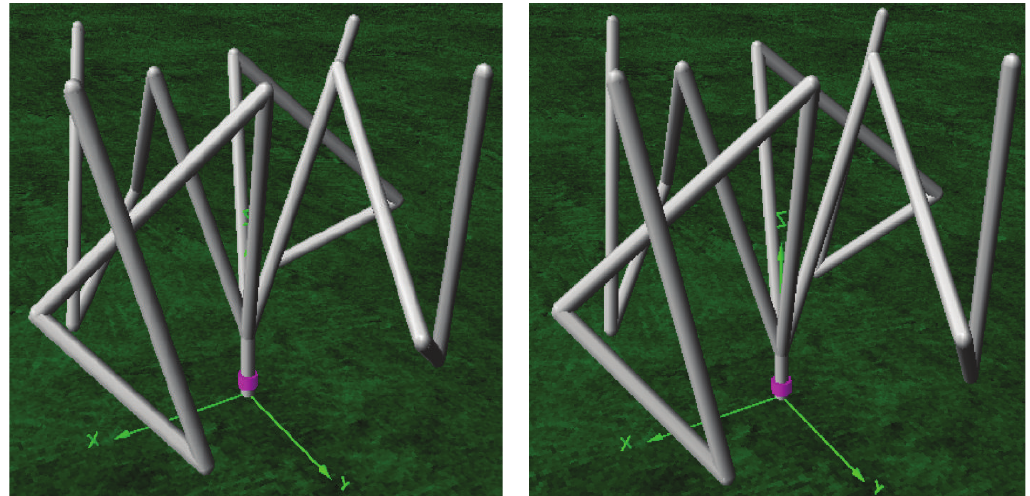
Figure 3: Structures of the antenna: the left is the roughly evolved one and the right the orthogonally designed one.